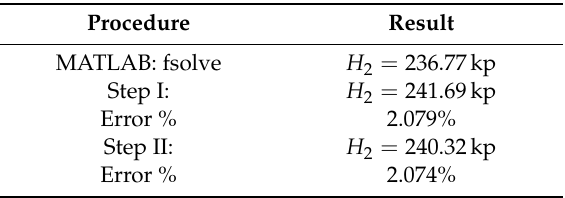
Table 9. Results for the cable RZ 3x150 Al / 80 Alm